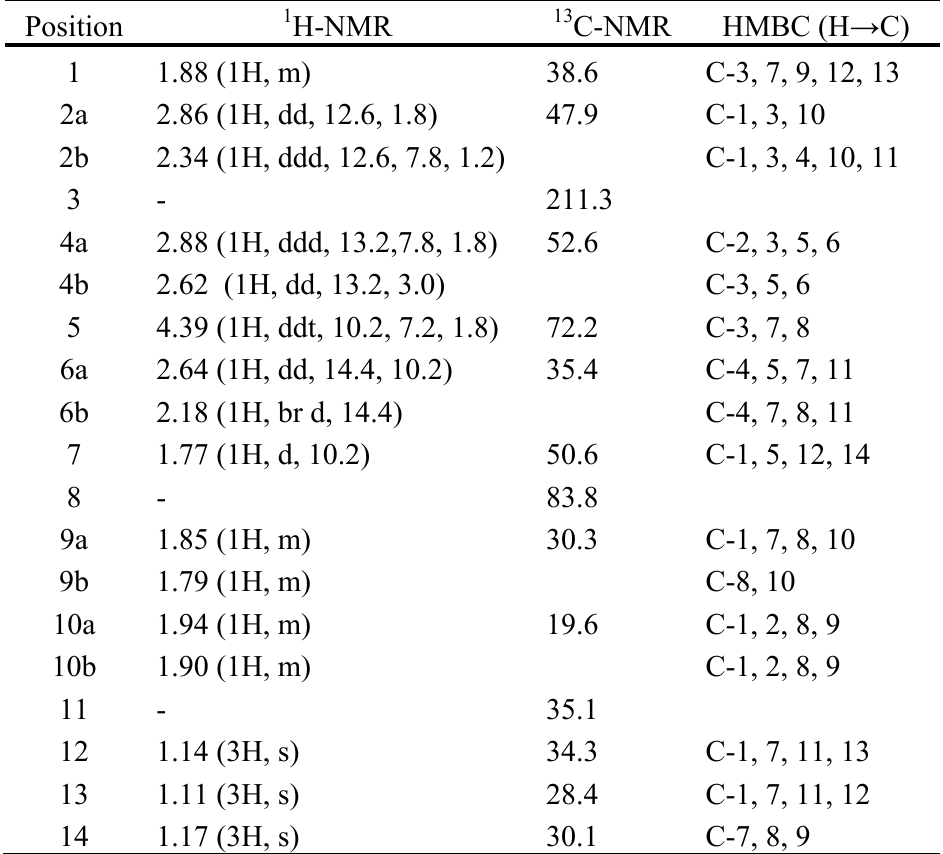
Table 1. The NMR data of compound 1 a